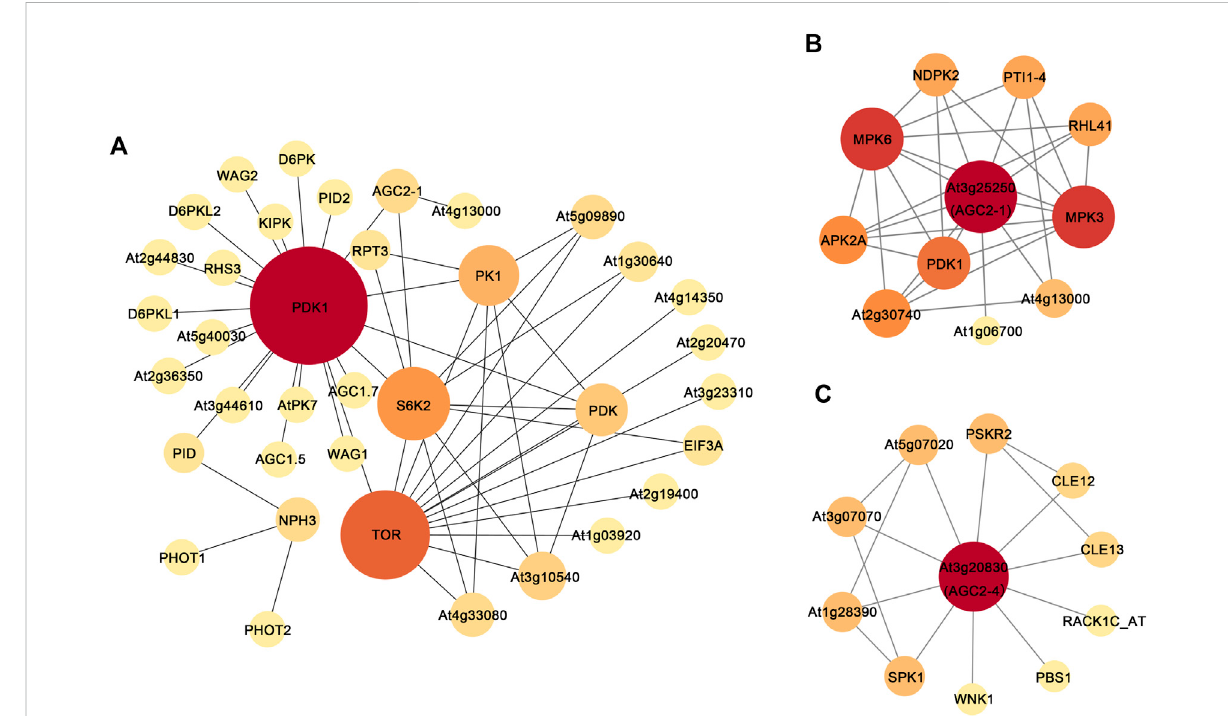
FIGURE 9 Protein-proteininteractionnetworksofAGCproteinkinasein A.thaliana . (A) AllAtAGCsPPIs. (B) At3g25250( BrAGC44 homologousgene)PPIs. (C) At3g20830 ( BrAGC26 and BrAGC33 homologous gene) PPIs. Each node represents a protein, and interacting protein connected by line. Node size and fi ll color shade are positively correlated with degree